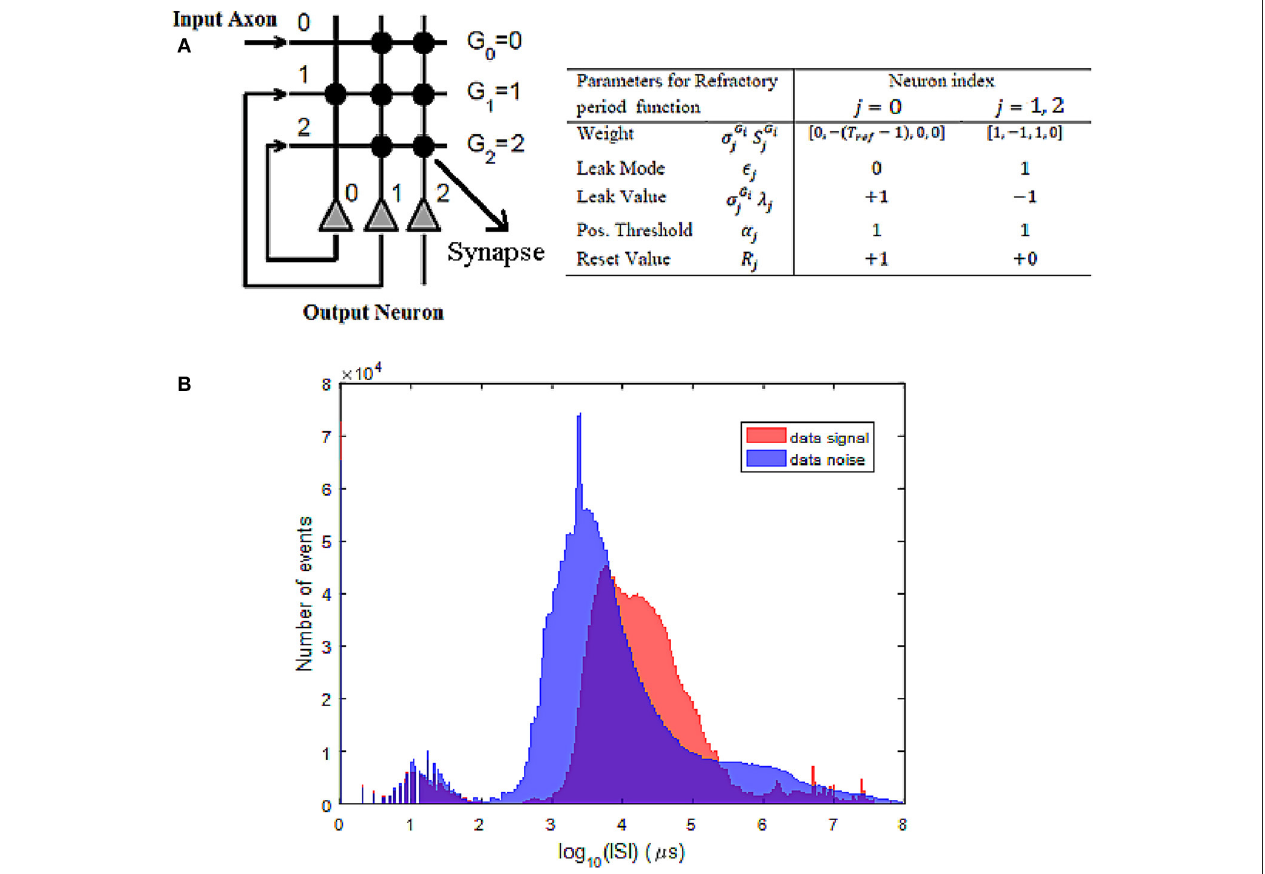
FIGURE 4 | (A) Connectivity mapping for refractory neuron function along with the neuronal parameters. (B) Statistics of the ISI for both signal and noise events show many noise events at ISI between 1 and 10 ms, whereas signal events mostly have ISI higher than 10 ms. This is used to choose a refractory period value in the range of 3–5